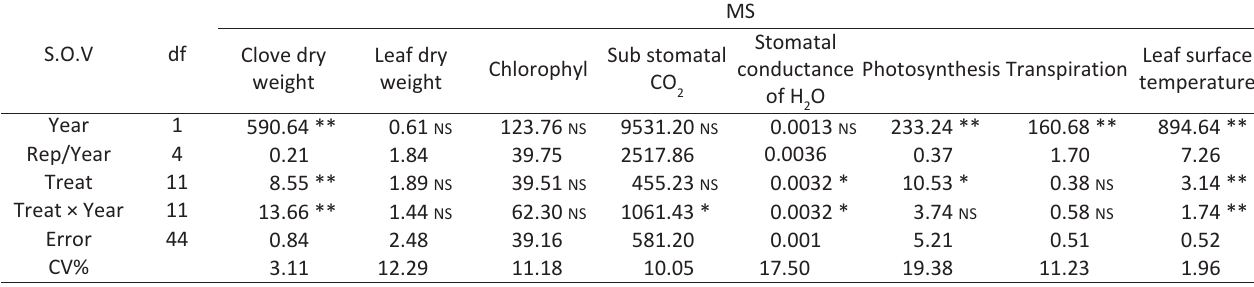
Table 3 ­ Results of combined analysis of variance for physiological characteristics in some Iranian garlic